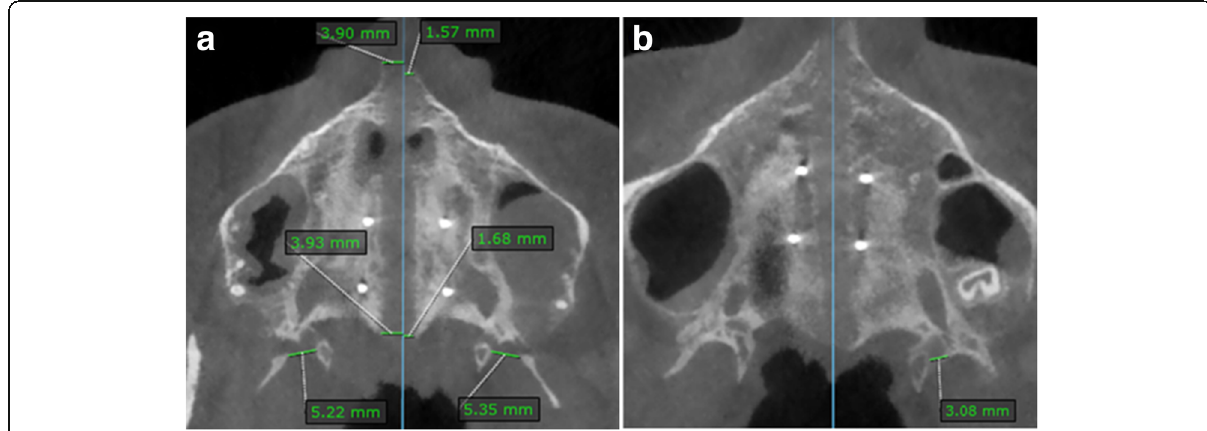
Fig. 7 Measurements on axial palatal section on post-expansion CBCT. Blue line, maxillary sagittal plane. a Patient with a complete disengagement of the pyramidal process from the pterygoid plates. b Patient with a partial disengagement of the pyramidal process from the pterygoid plates in the left pterygopalatine suture; the opening is present between the pyramidal process and the medial pterygoid